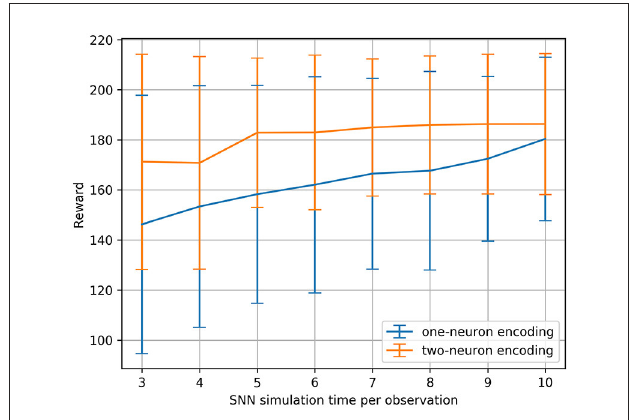
FIGURE4 CartPole-v0 reward means and standard deviations measured across all membrane parameter combinations (for the defined ranges) for different SNN simulation times using one-neuron and two-neuron encoding. Running a statistical t -test on the rewards resulted in the significance values: t 8.17, p < 0.001. = −